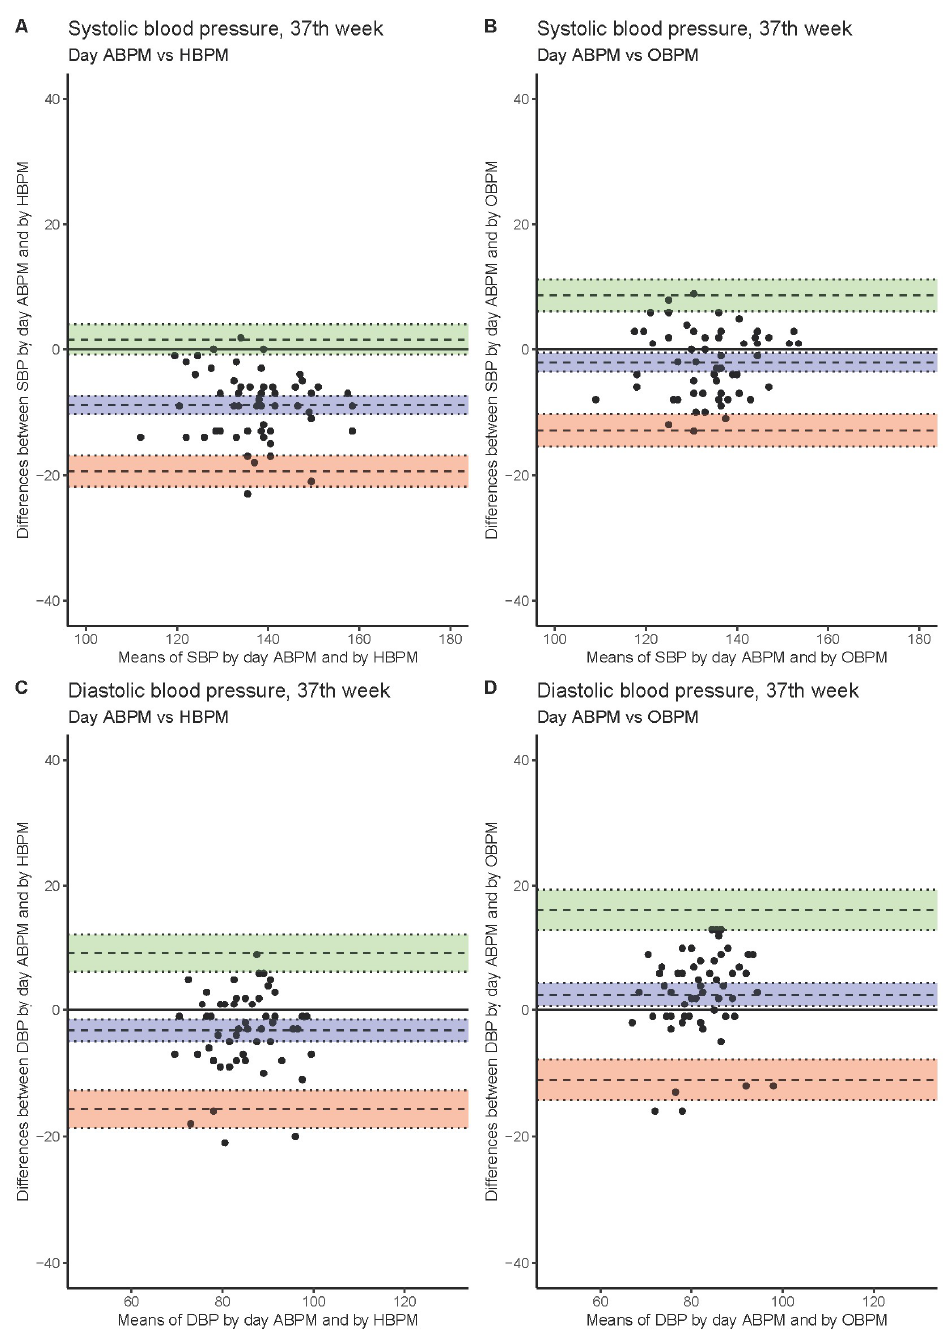
Figure 3. The agreement between systolic blood pressure values obtained by day ABPM vs. HBPM ( A ) and day ABPM vs. OBPM ( B ). Diastolic blood pressure measured by day ABPM vs. HBPM ( C ) and day ABPM vs. OBPM ( D ) in 37th week of gestation. For each patient difference and mean of blood pressure values obtained by two methods was calculated and plotted (black dots). Mean of differences is presented as bias with computed 95% confidence interval (blue). Upper and lower limits of agreement with 95% confidence intervals are presented using green and pink colors, re- spectively.